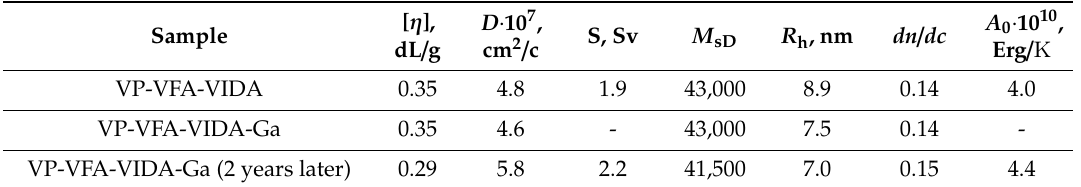
Figure 3. 1 Н NMR spectra (D 2 O): (a) the initial copolymer VP-VFA-VIDA; ( A ) VP-VFA-VIDA-Ga 3 + ; ( B ) spectrum of the model complex Na[Ga(IDA) 2 ]; ( C , D ) signals of 2, 2”6, 6 (cid:48) 6, 6”, 6 protons. Table 2. Molecular characteristics of the initial copolymer and MPC in 0.2 М NaCl solution calculated using the value of hydrodynamic invariant A 0